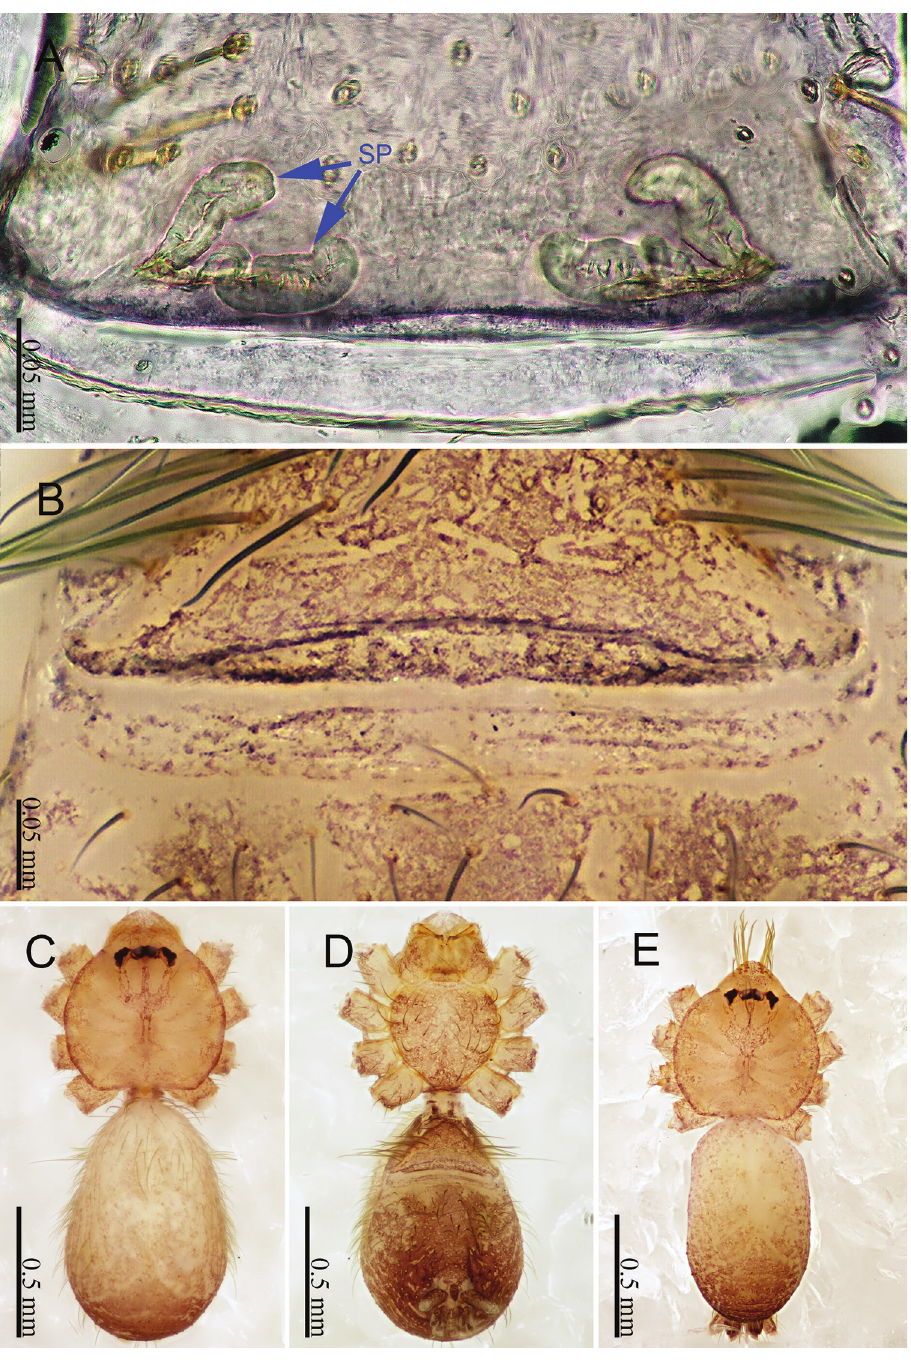
Figure 16. Sinoderces aiensis Li & Li, sp. nov., male holotype and female paratype A internal genitalia, dorsal view B female epigastric furrow, ventral view C female habitus, dorsal view D female habitus, ventral view E male habitus, dorsal view. Abbreviation: SP